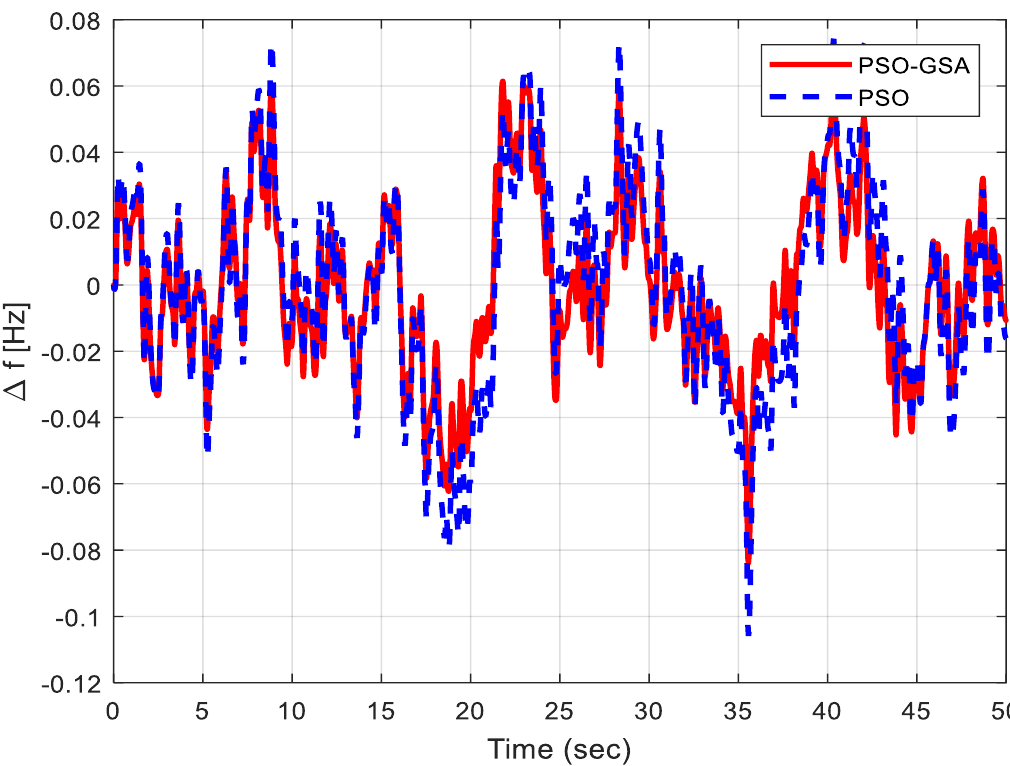
Figure 7. Frequency changes with and without a PID controller.